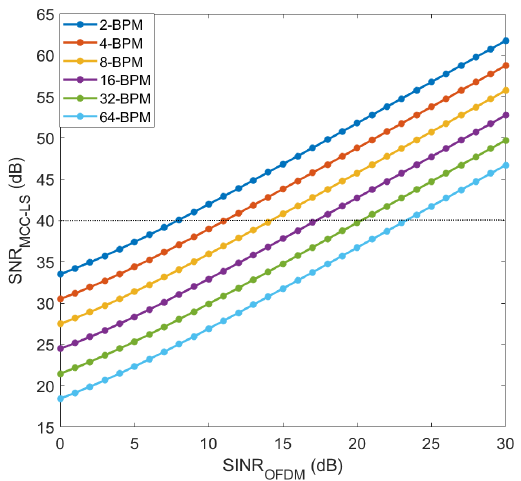
Figure 11. SNR requirements for MCC-LS with respect to SINR OFDM for varying L 1 − BPM modula- tion orders at target BER for